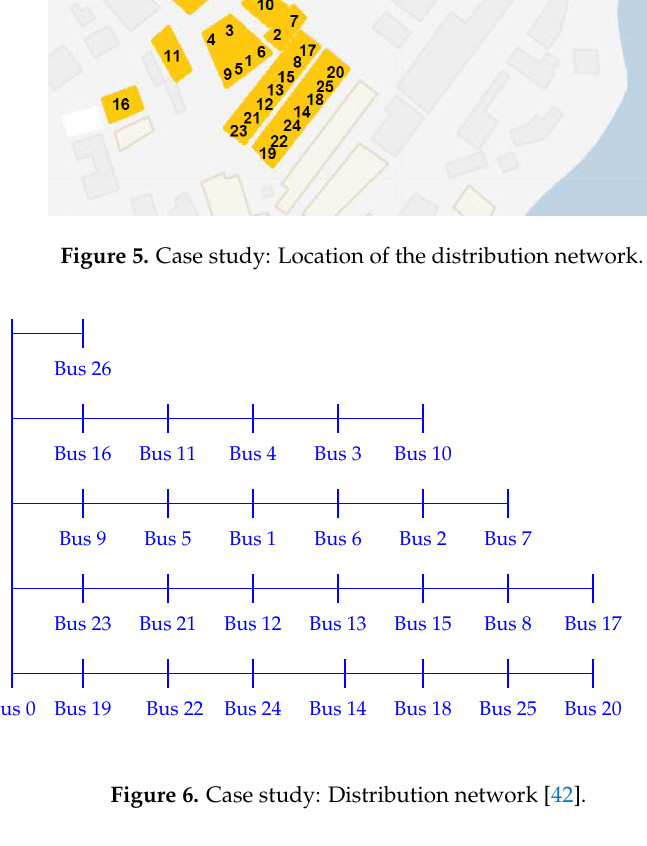
Table 4. Case study: input